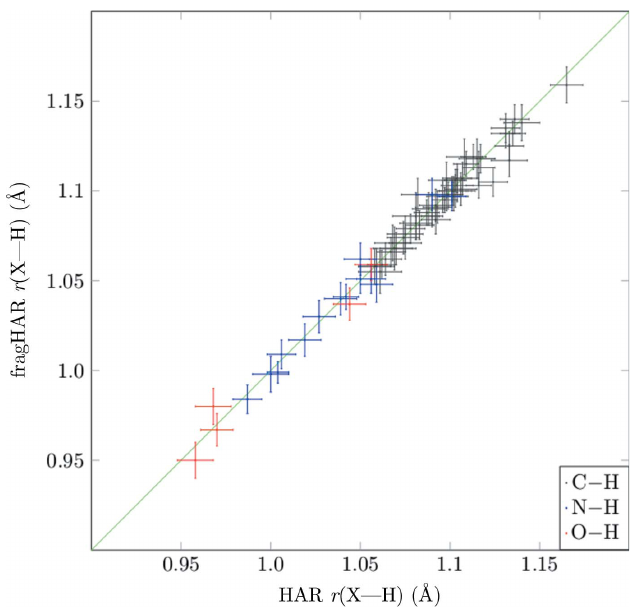
Figure 5 X —H bonds (with error bars) in all model compounds for fragHAR with fragments ‘joined’ across hydrogen bonds versus reference HAR calculations.